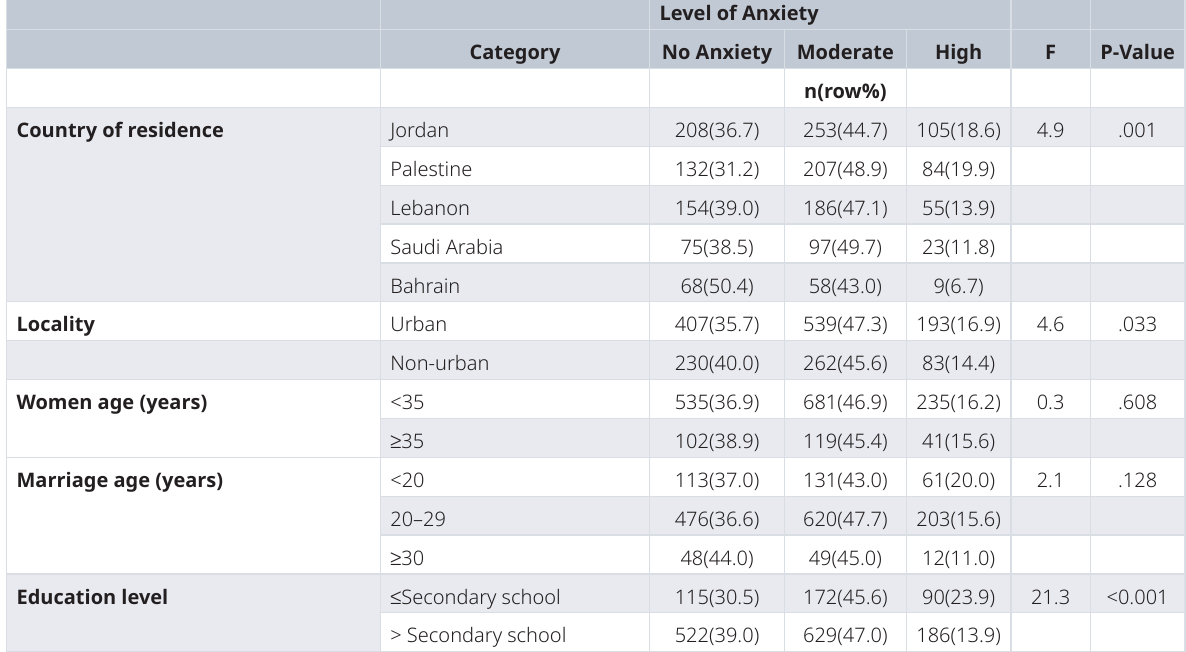
Table 3. Descriptive analysis of study variables and maternal